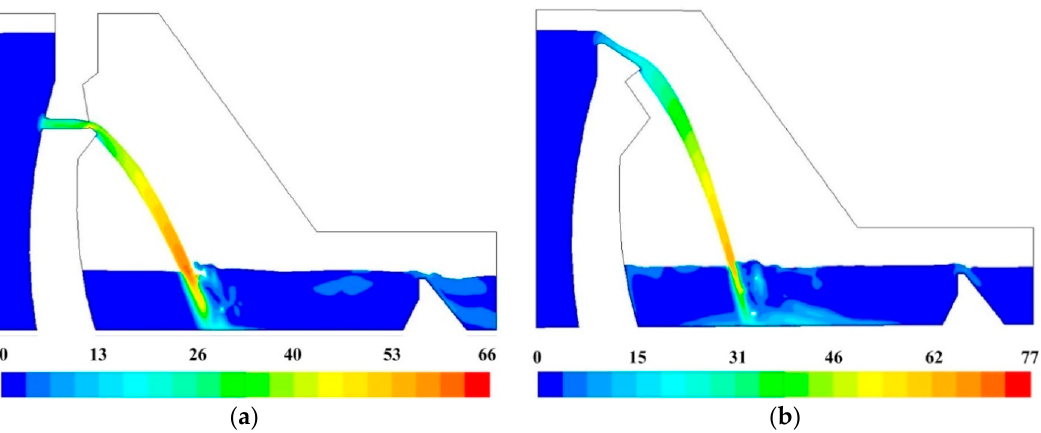
Figure 9. Velocity contours of the surface and deep outlet’s mid ‐ line sections (the unit is m/s): ( a ) Condition 2; ( b ) Condition 6.